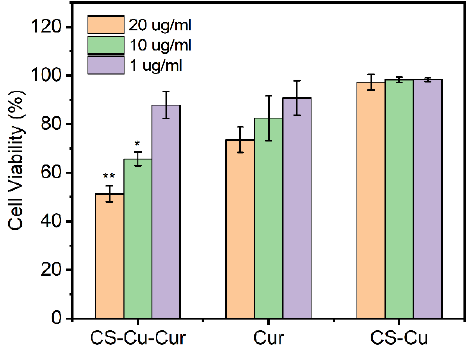
Figure 10. In vitro cytotoxicity of the Cur-loaded CS nanocomplex, free Cur, and CS-metal complex against H1299 cells incubated for 24 h. In all panels, the indicated concentrations are Cur doses. It should be noted that for evaluating Cur-loaded CS nanocomplex, equal concentrations of CS-metal complex were employed to eliminate the effect of vehicles in MTT assay. Error bars denote the standard deviation (n = 6). * and ** indicate significant (p < 0.05) and highly significant ( p < 0.01) differences between Cur-loaded CS nanocomplex and free Cur.